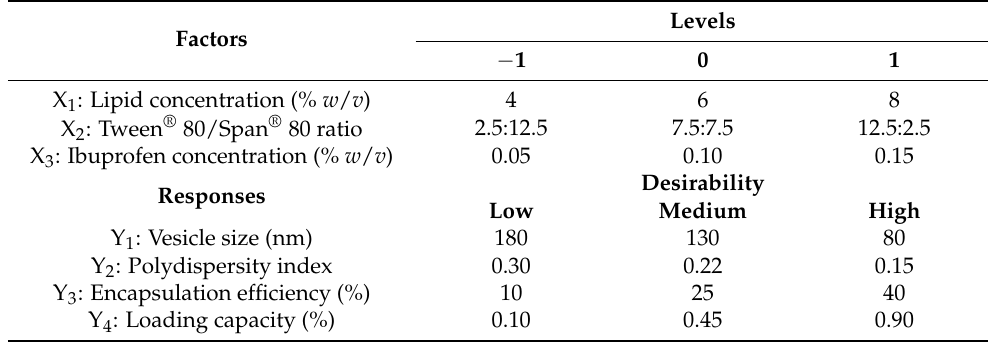
Table 1. Factors and responses selected for the BBD and their respective tested levels and desirability